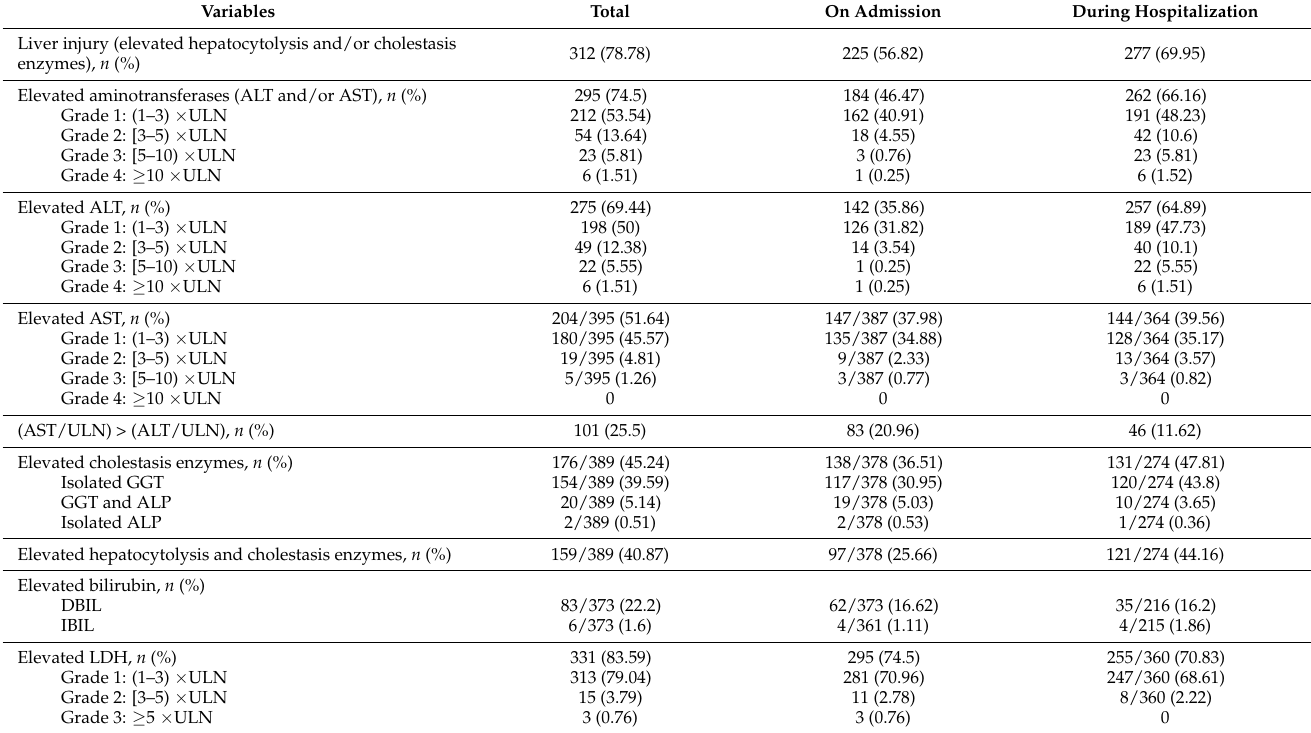
Table 3. Characteristics of liver injury in the study